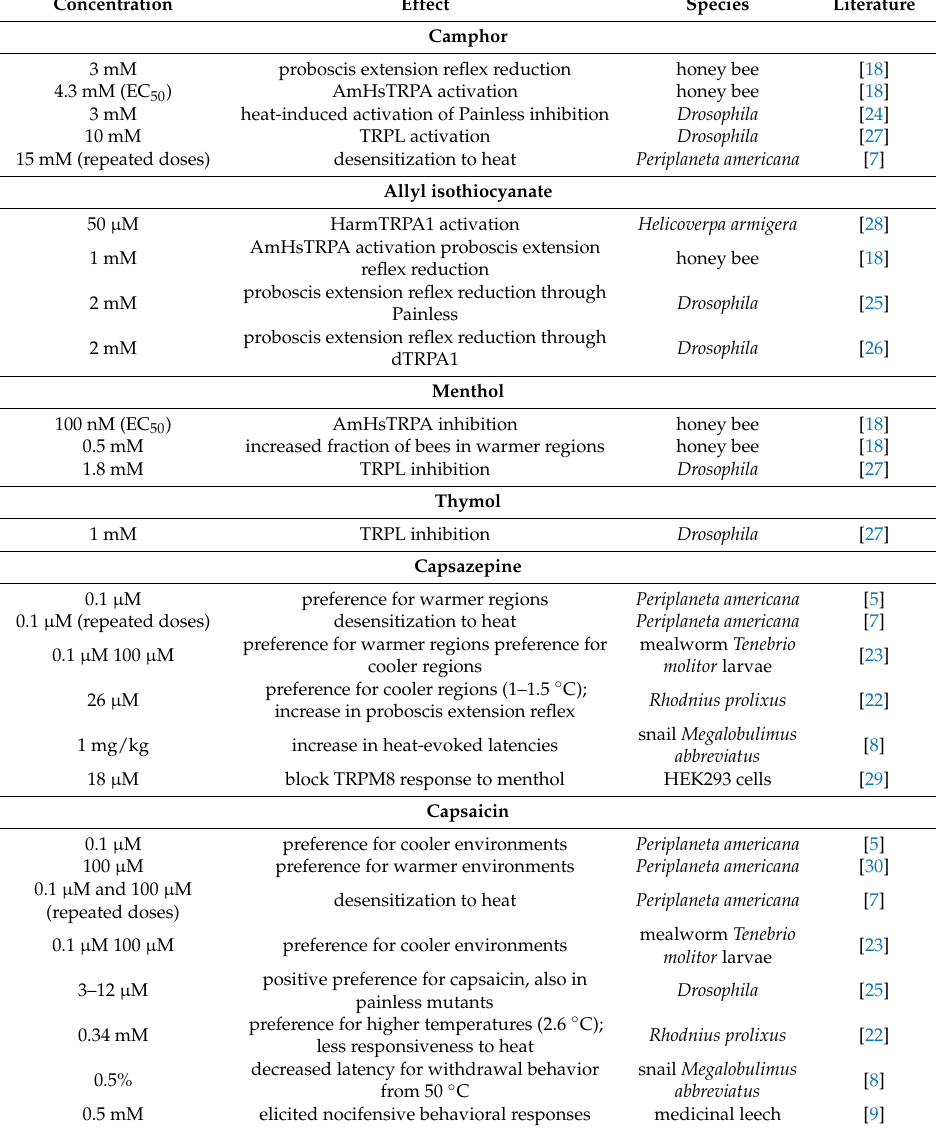
Table 2. Effect of different ligands on invertebrates’ TRP